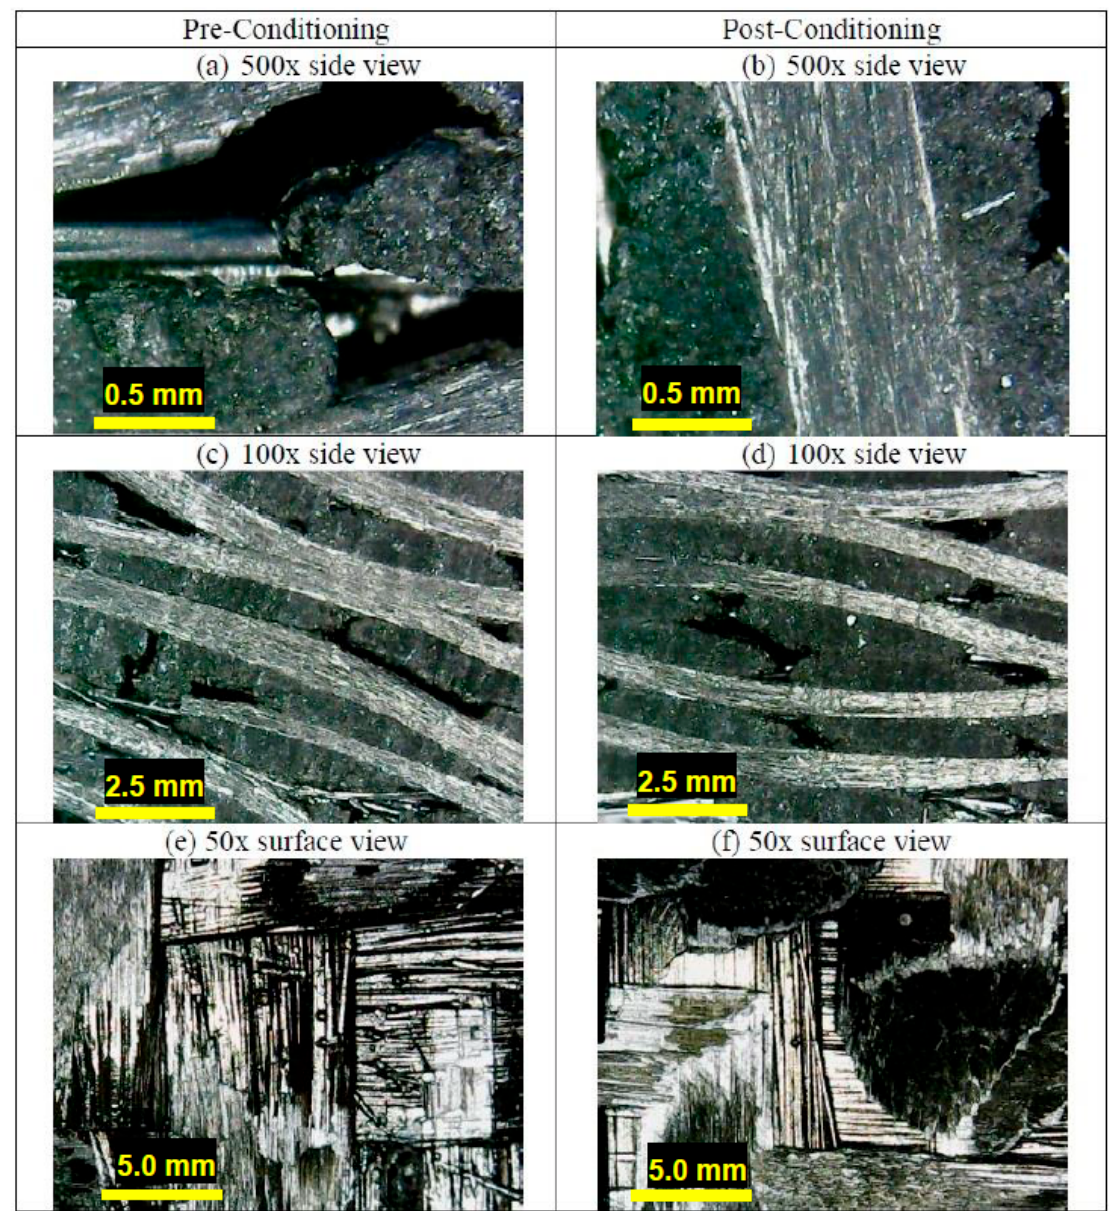
Figure 9. Optical images of the C/C samples. Table 4. The coefficient of thermal expansion (CTE) measurement results for C/C samples.